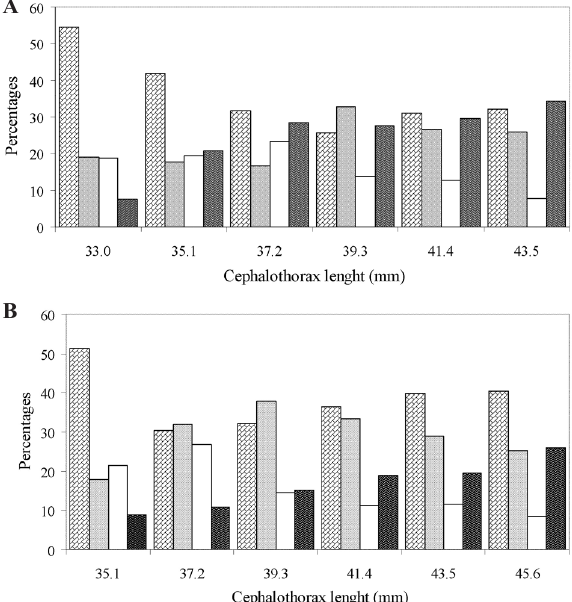
Figures 4. Percentages of cysts of Microphallus nicolli by development stage of cysts and size-classes of female crabs ( Emerita rathbunae ). Hatched bars = immature cysts; Shaded bars = late immature cysts; Open bars = mature cysts; Dark bars = melanized cysts. Data are only from San Andrés ( A ) and Las Trancas beaches ( B ). Stages of cyst maturity were modified from Keeney et al. (2007).